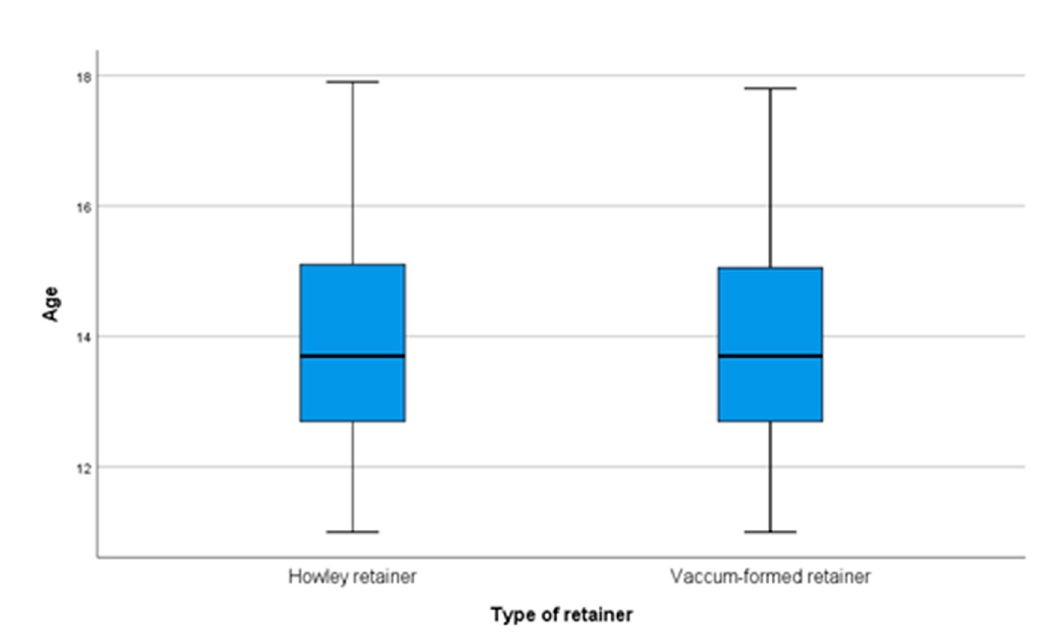
Figure 4. Comparison of patients’ age according to the type of retainer.